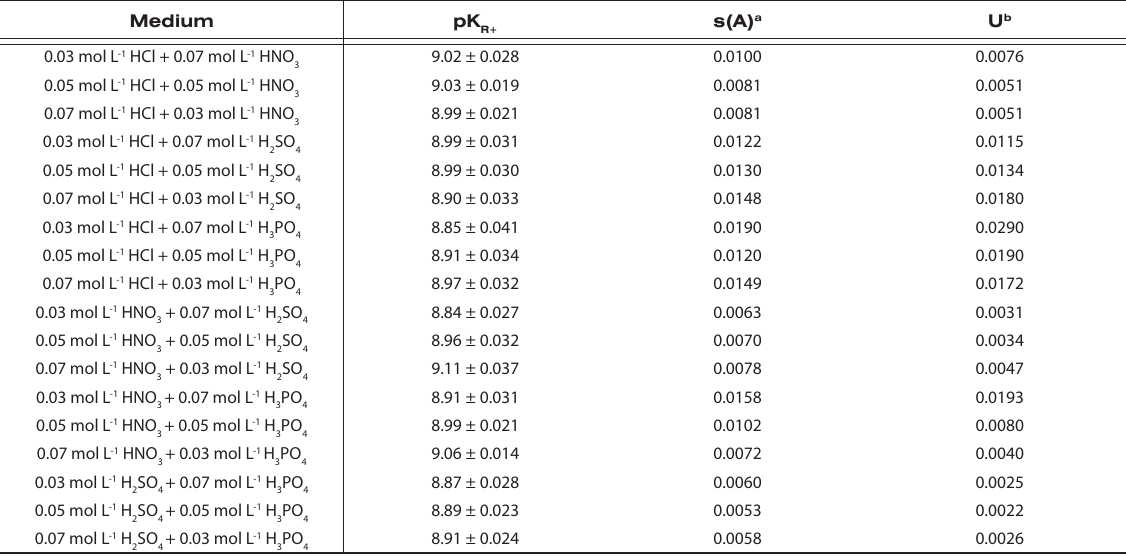
= 6.5 µmol L -1 , c = 0.1 mol L -1 mineral acid, pH adjusted by NaOH). CHE HA